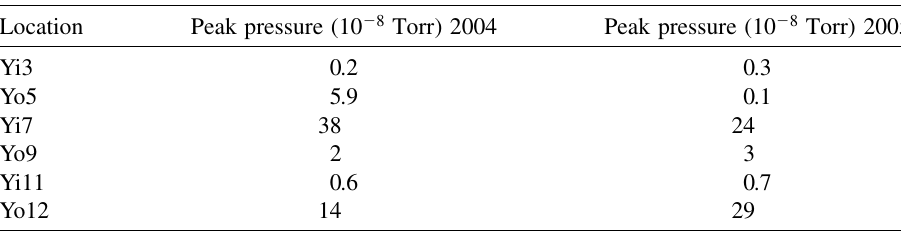
TABLE I. Peak pressure rise at Yo5, where ridges were installed for the 2005 run, and at the other 5 straight sections without changes between 2004 and